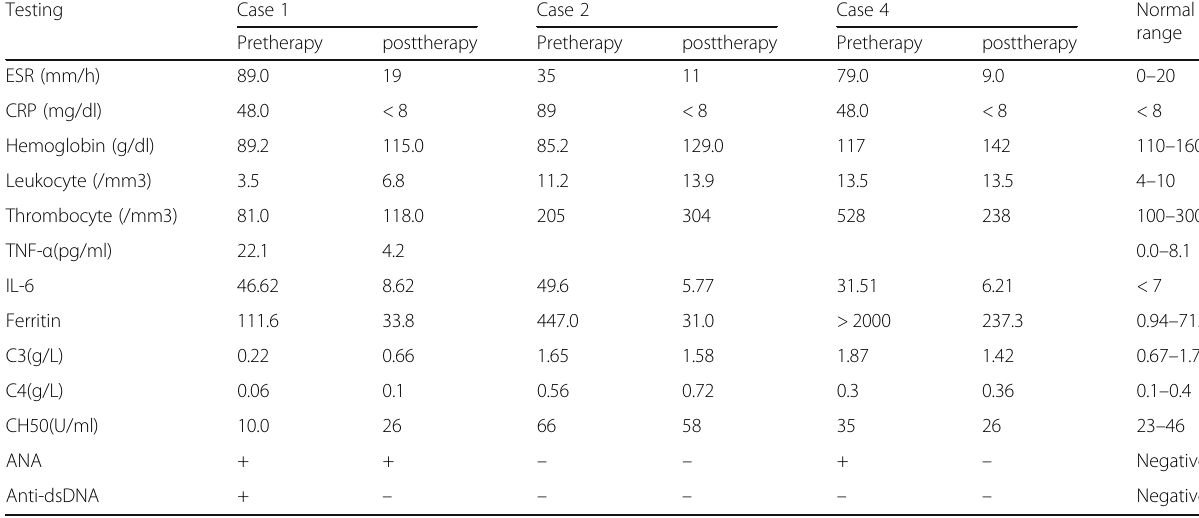
Table 3 Laboratory findings of patients with HA20